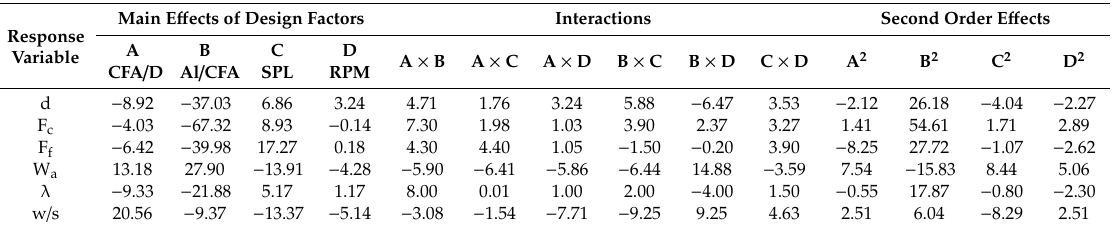
Table 5. Standardized values of main e ff ects, interactions, and second order e ff ects of design factors on the response